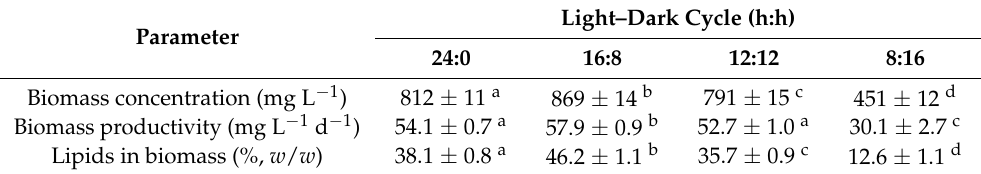
Table 3. Dependence of biomass and lipid production on the light–dark cycle. Light–Dark Cycle (h:h) Parameter 24:0